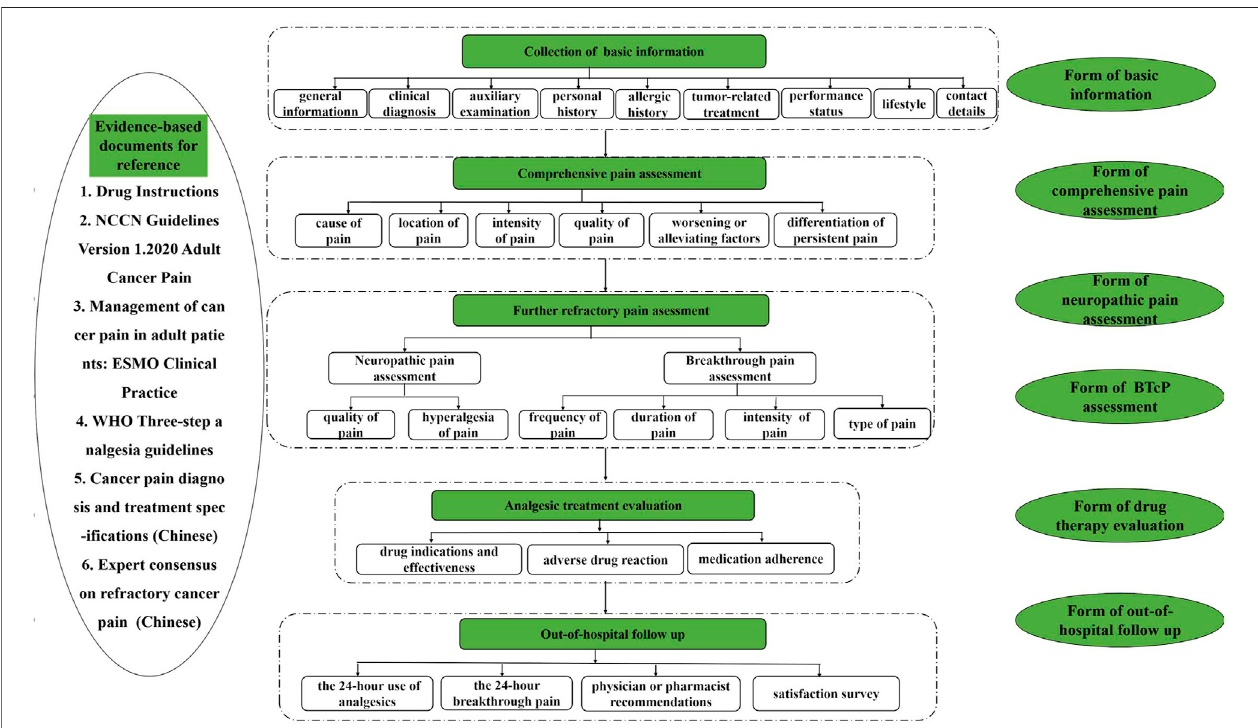
FIGURE 2 | The fl owchart of the practice of pharmaceutical care for cancer pain management in outpatient clinics.